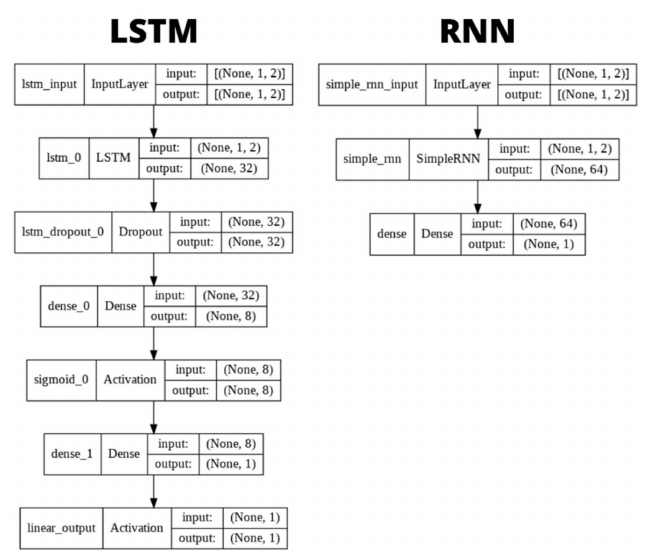
Figure 12. Neural Networks’